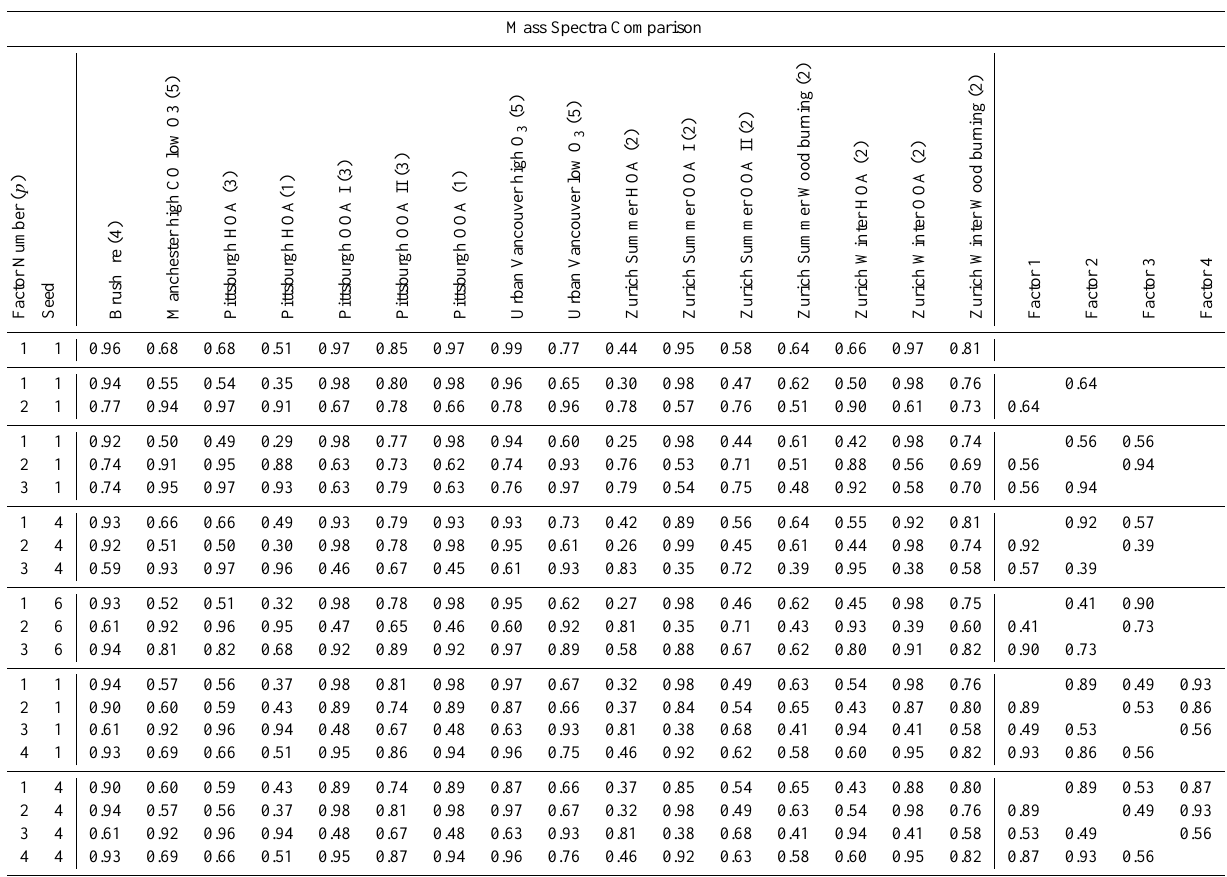
Table A1. Mass spectral comparison of several PMF solutions.